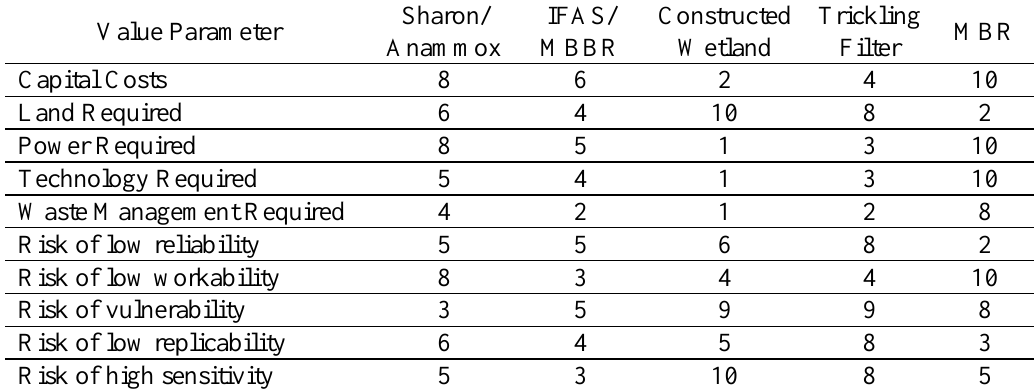
Table 3. The value allocated based on different sub criteria (from 1 to 10 points) Value Parameter